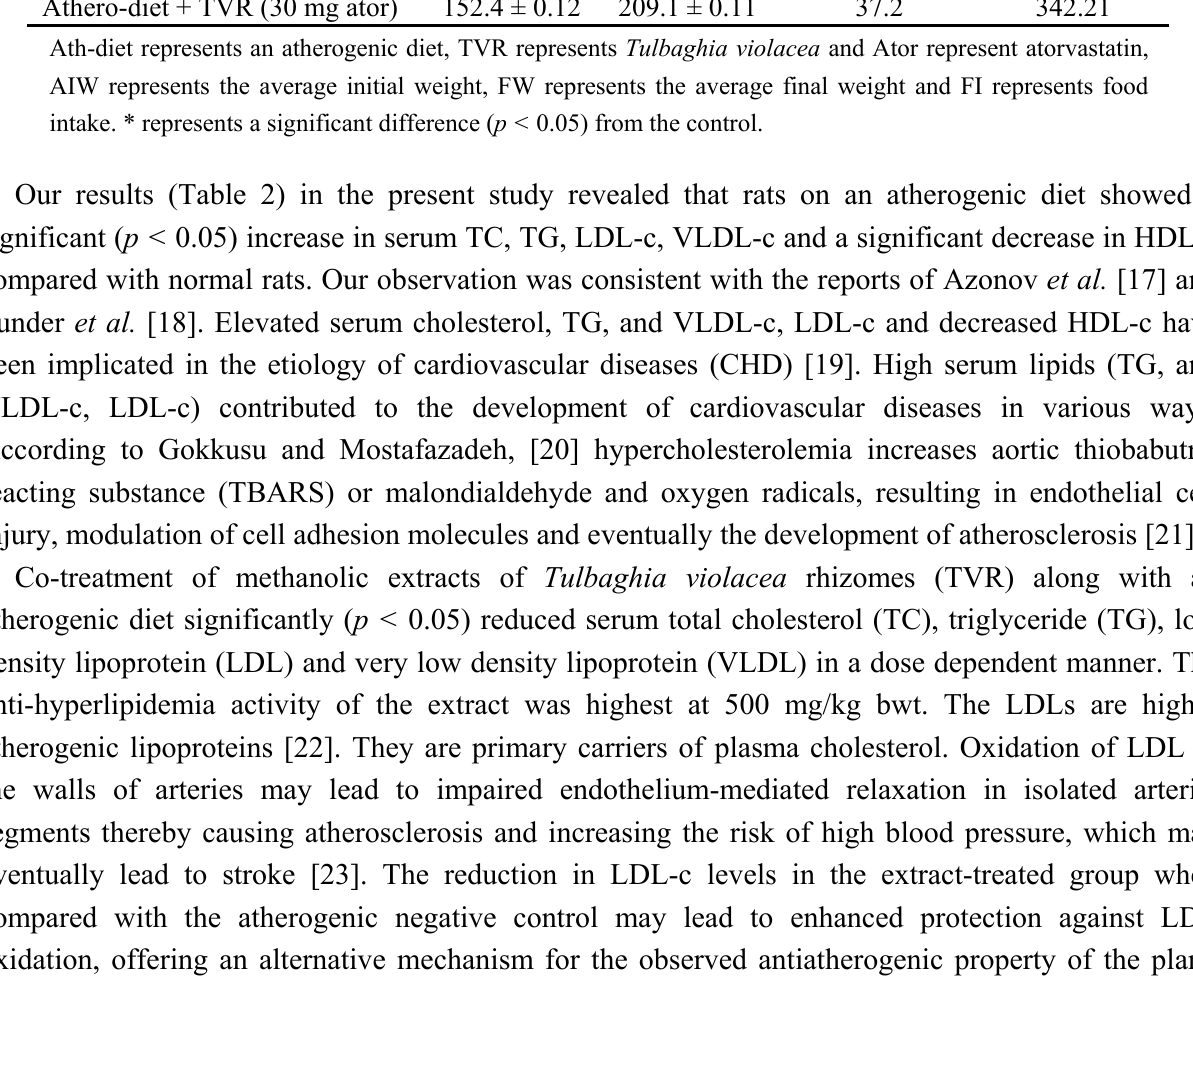
Table 1. Food intake, body weight and percentage of weight gain of experimental groups. Treatment AIW (g) AFW % weight gain FI (g/2 weeks) Control 151.0 ± 0.11 208.0 ± 0.14 38.0 152.1 ±